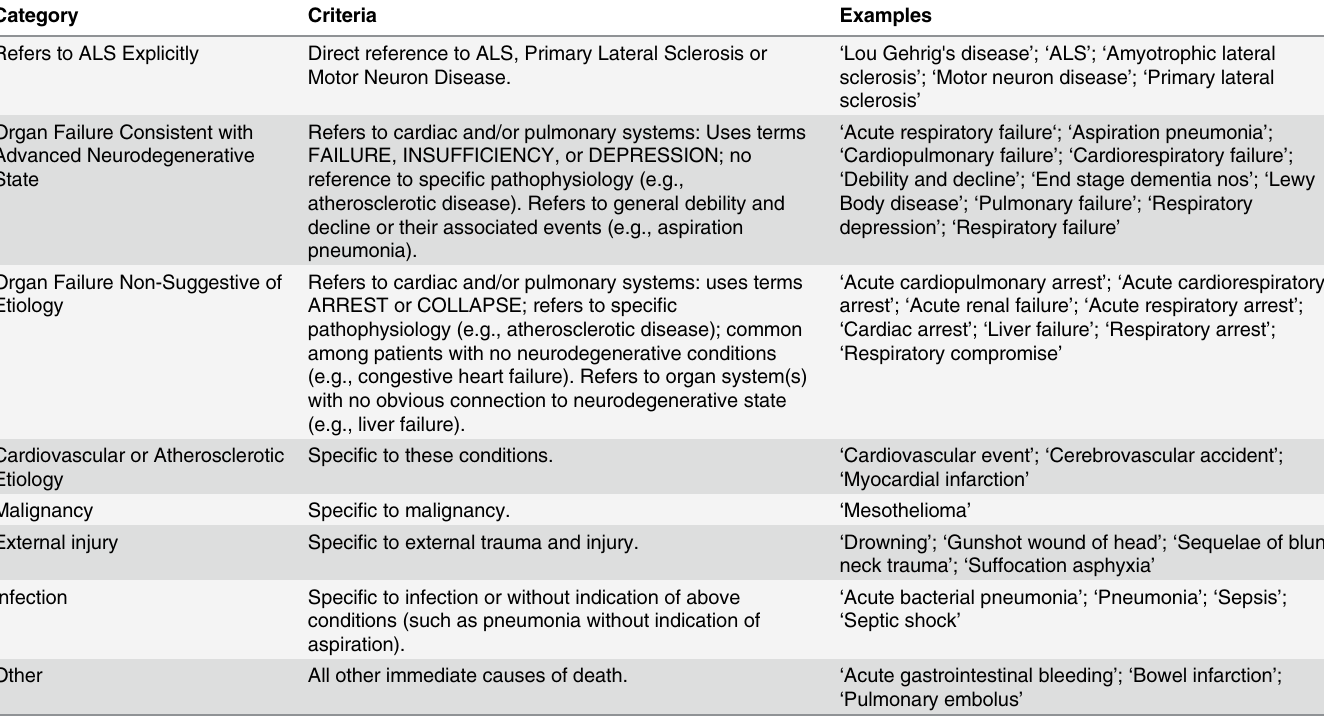
Table 1. Categorized Text Strings of Immediate Causes of Death on Death Records of Confirmed ALS Cases Residing in Los Angeles County and Selected San Francisco Bay Area Counties (Diagnosed 2009 – 2011, Deceased 2009 – 2013).